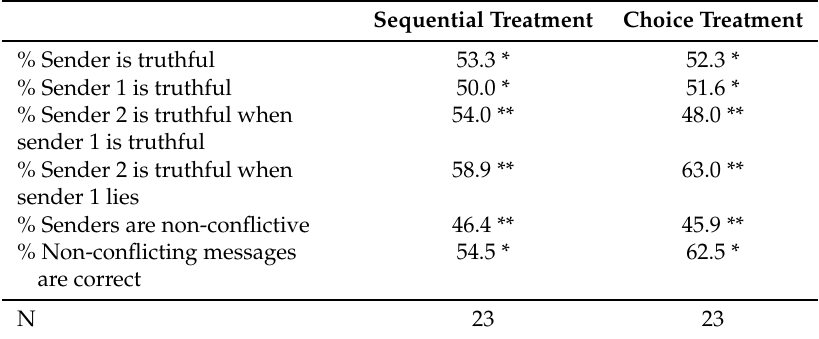
Table 3. Sender Behavior with Sequential Messages a .